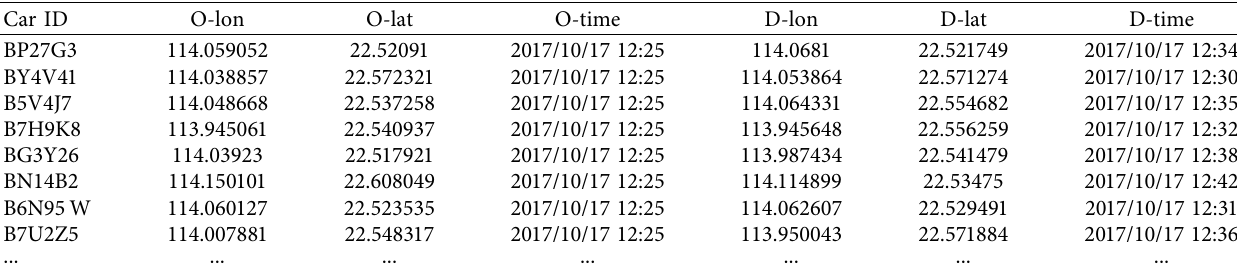
Figure 1: Shenzhen street segments and statistical units. Table 1: Taxi data